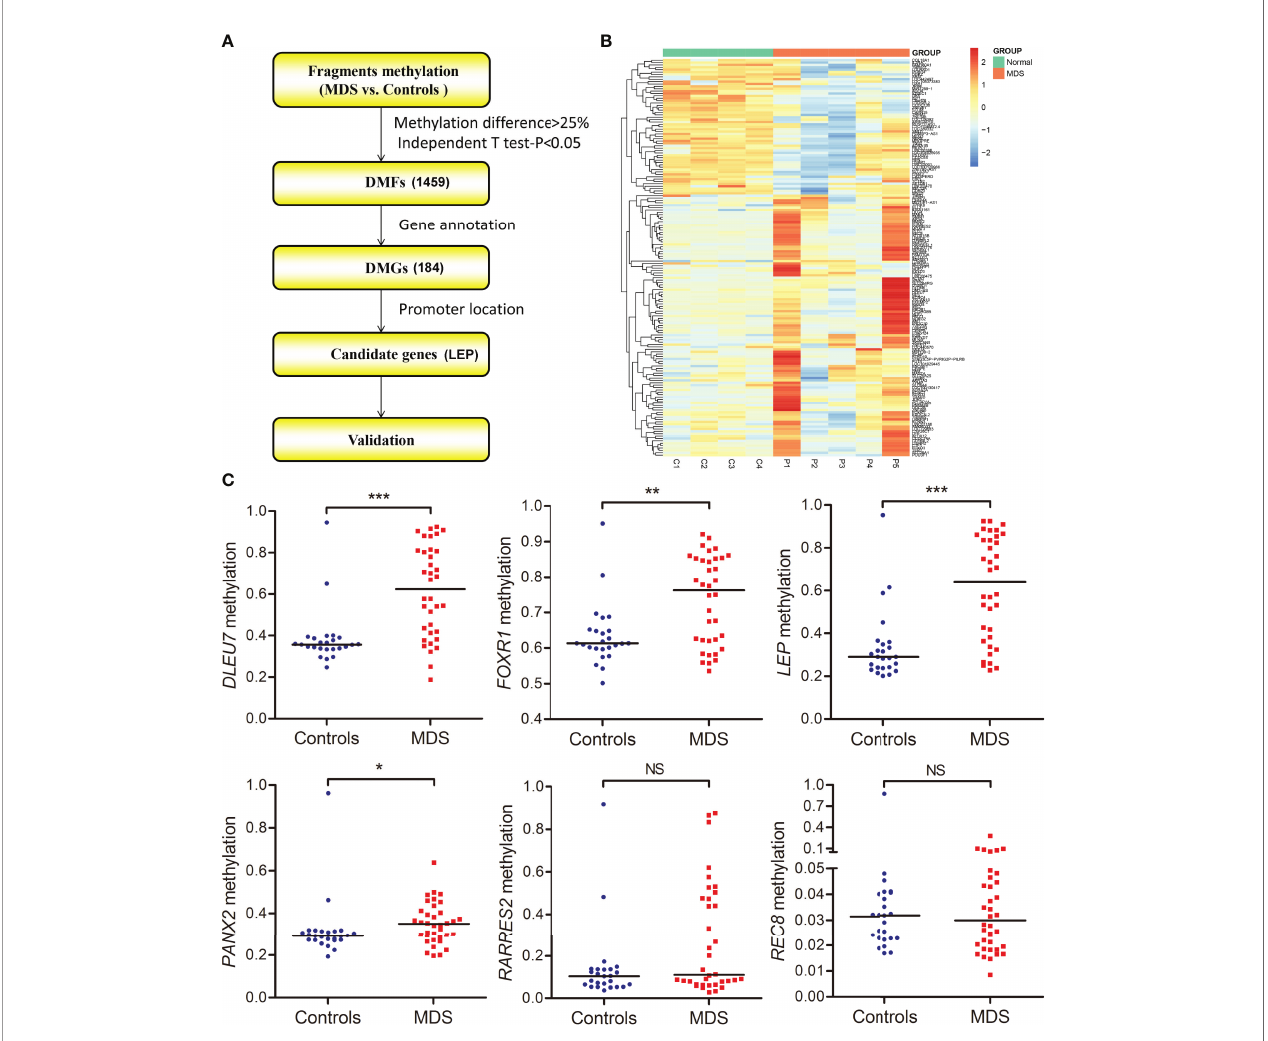
FIGURE 3 | Identi fi cation and validation of differentially methylated genes in MDS. (A) The fl owchart of the differentially methylated genes screening. The fragments that passed statistical signi fi cance ( P < 0.05, Q < 0.05 and also had > 25% mean methylation difference) were considered as differentially methylated fragments/ genes. (B) Heatmaps summarizing differentially methylated fragments/genes in MDS. (C) The methylation level of the candidate genes in additional samples of de novo MDS (n = 36) and controls (n = 25) analyzed by targeted bisul fi te sequencing. P -values were calculated using the Mann – Whitney U-test. NS, no signi fi cance; * P < 0.05; ** P < 0.01; *** P <